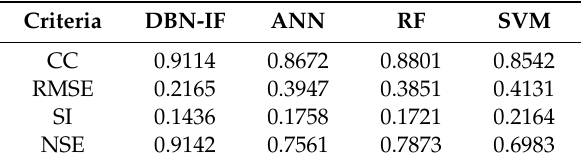
Table 14. The CC, RMSE, SI, NSE of WVHT predictions with lead time = 6 h. Criteria